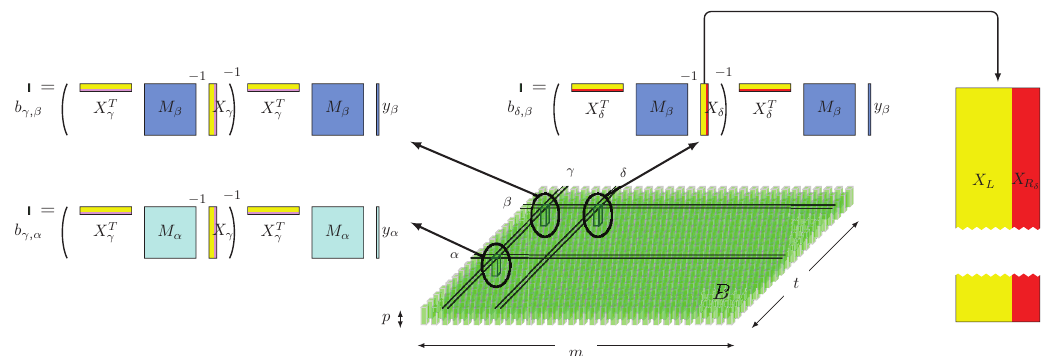
Figure 1. Interpretation of multi-trait GWAS as a two-dimensional grid of generalized least-squares problems ( b := ( X T M -1 X ) -1 X T M -1 y ). GWAS with multiple phenotypes requires the solution of m × t correlated Generalized Least-Squares (GLS) problems, originating a three- dimensional object B of size m × t × p . Along the t direction, the variance-covariance matrix M and the phenotype y vary, while the design matrix X does not; conversely, in the m direction, M and y are fixed while X varies. Specifically, X can be viewed as consisting of two parts, X and X , where the former is constant across the entire grid and the latter changes along m . The figure also captures GWAS with single L R phenotype, in which case the dimension t reduces to 1.